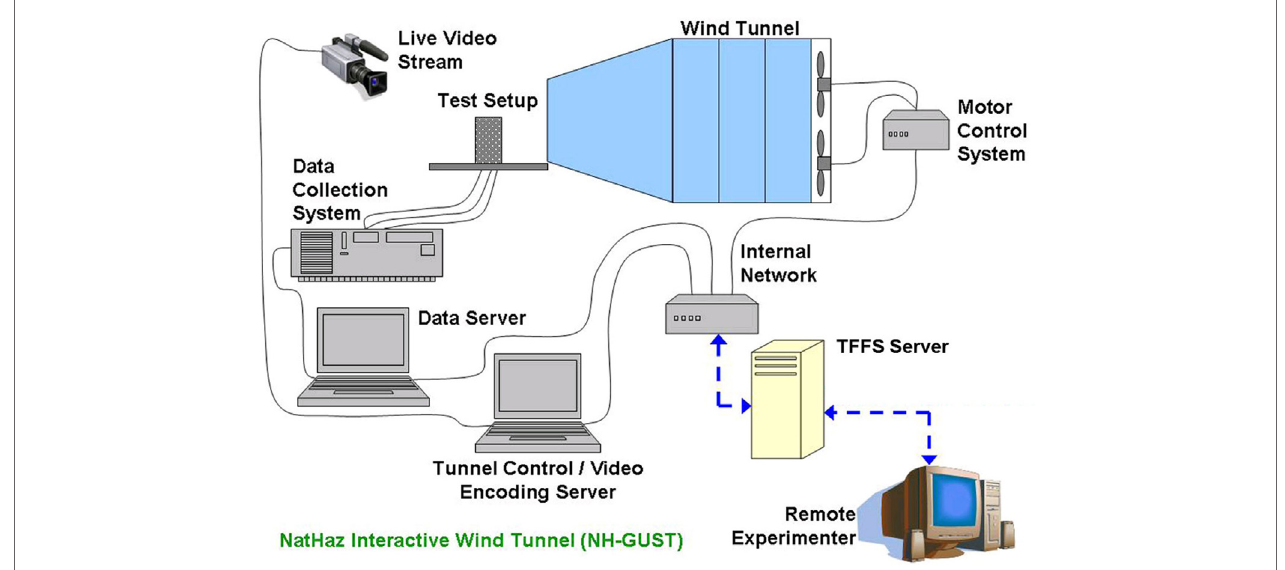
FigUre 11 | Prototype system for an interactive wind tunnel capable of generating gust-like events for remote